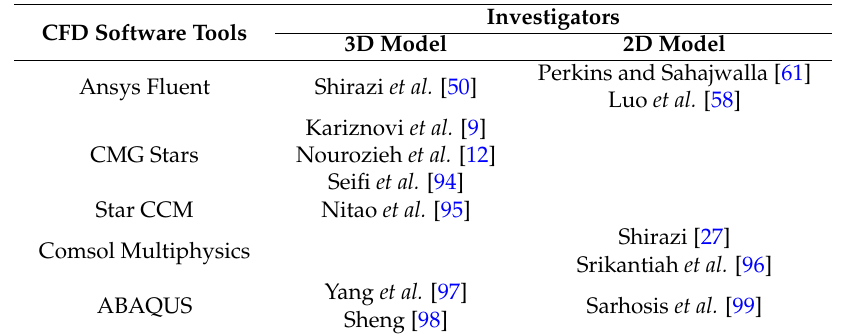
Table 20. List of the researchers who used CFD software tools in order to develop their UCG model,